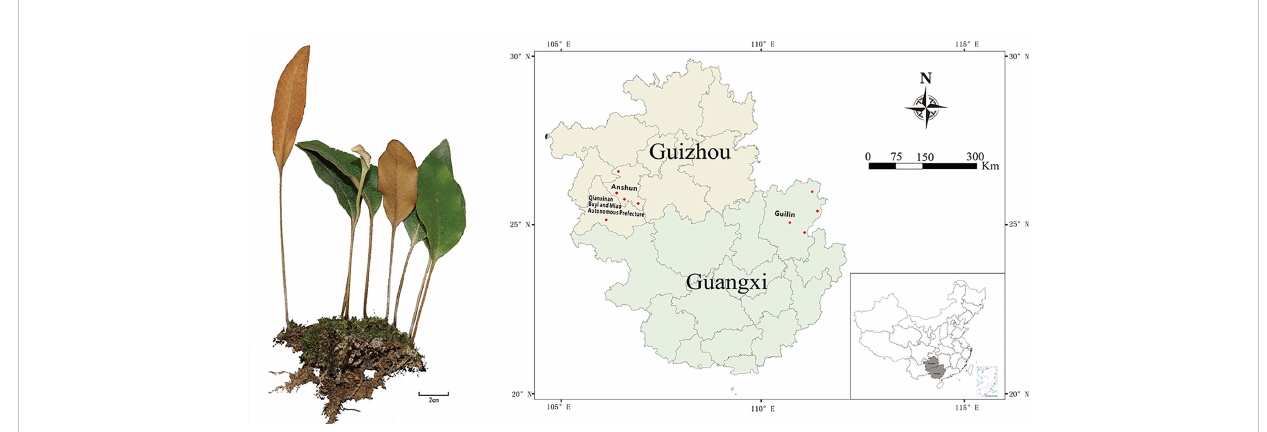
FIGURE 1 Geographical locations of P. petiolosa samples. For names of the numbered positions and ecogeographic information see Supplementary Table